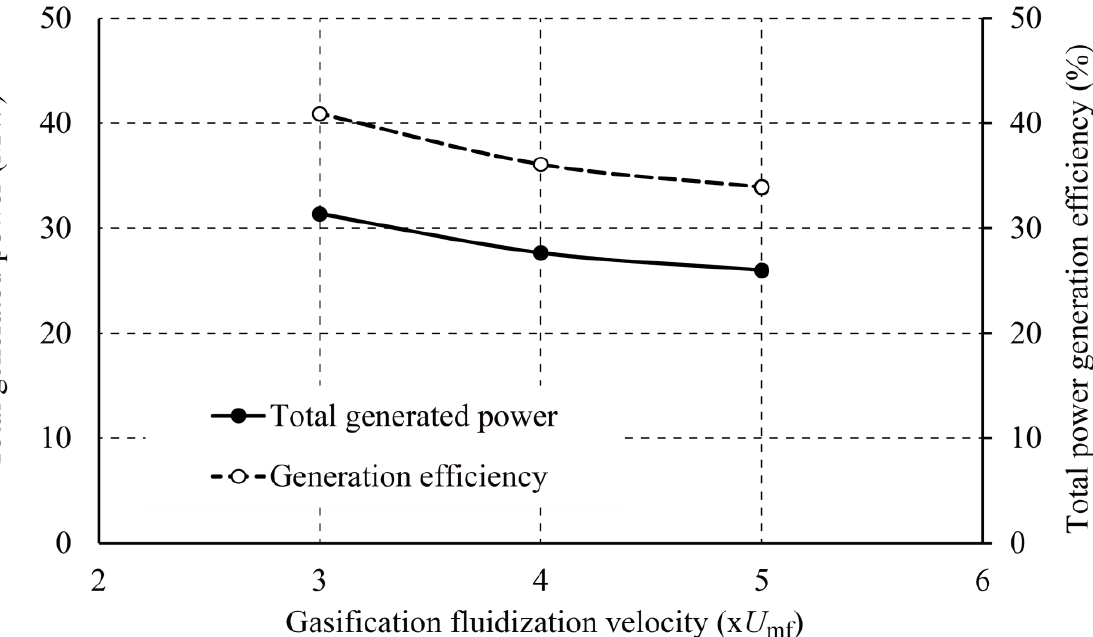
Figure 7. Correlation of fluidization velocity to total generated power and power generation